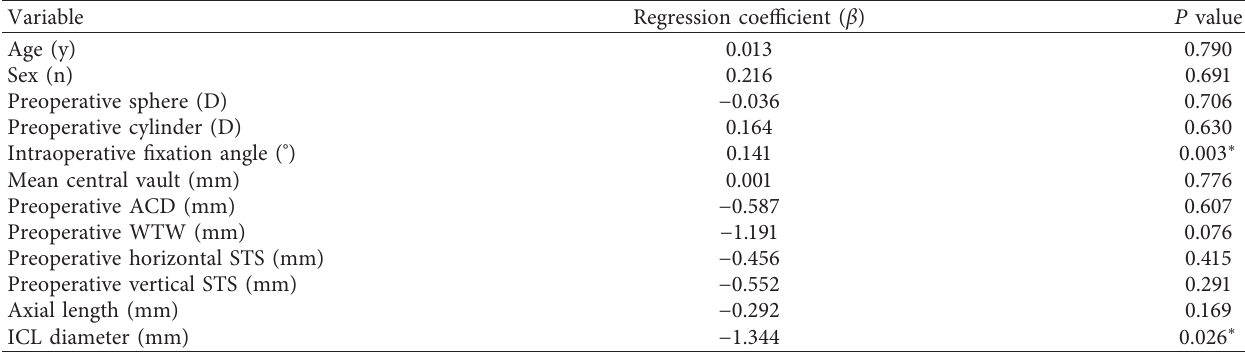
Table 4: Ordered, multinomial regression to analyze the association between postoperative TICL rotation and intraoperative fixation angle. Category Mean rotation ( ° ) Rotation < 5 ° Fixation angle ≥ 10 ° OR � odds